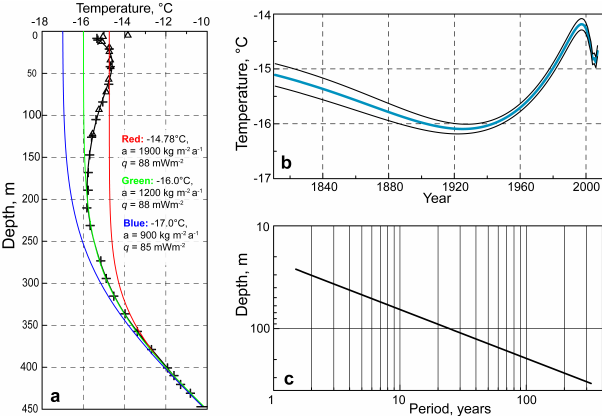
Fig. 2. (a) Borehole temperatures measured at LARISSA Site Beta and steady state model results used for estimating the range of geothermal heat flux and mean accumulation. Crosses are the thermistor-measured values for L-Bb; triangles are PRT-measured mean temperatures in L-Ba spanning five months; the colored lines are steady state model results that bound the likely range of con- ditions for the profile (see the text for the parameters). Panel (b) is the inverted T s temperature history (blue) and possible error (black) proportional to instrumental inaccuracy of 0.1 ◦ C; panel (c) is atten- uation depth of surface temperature oscillations in the